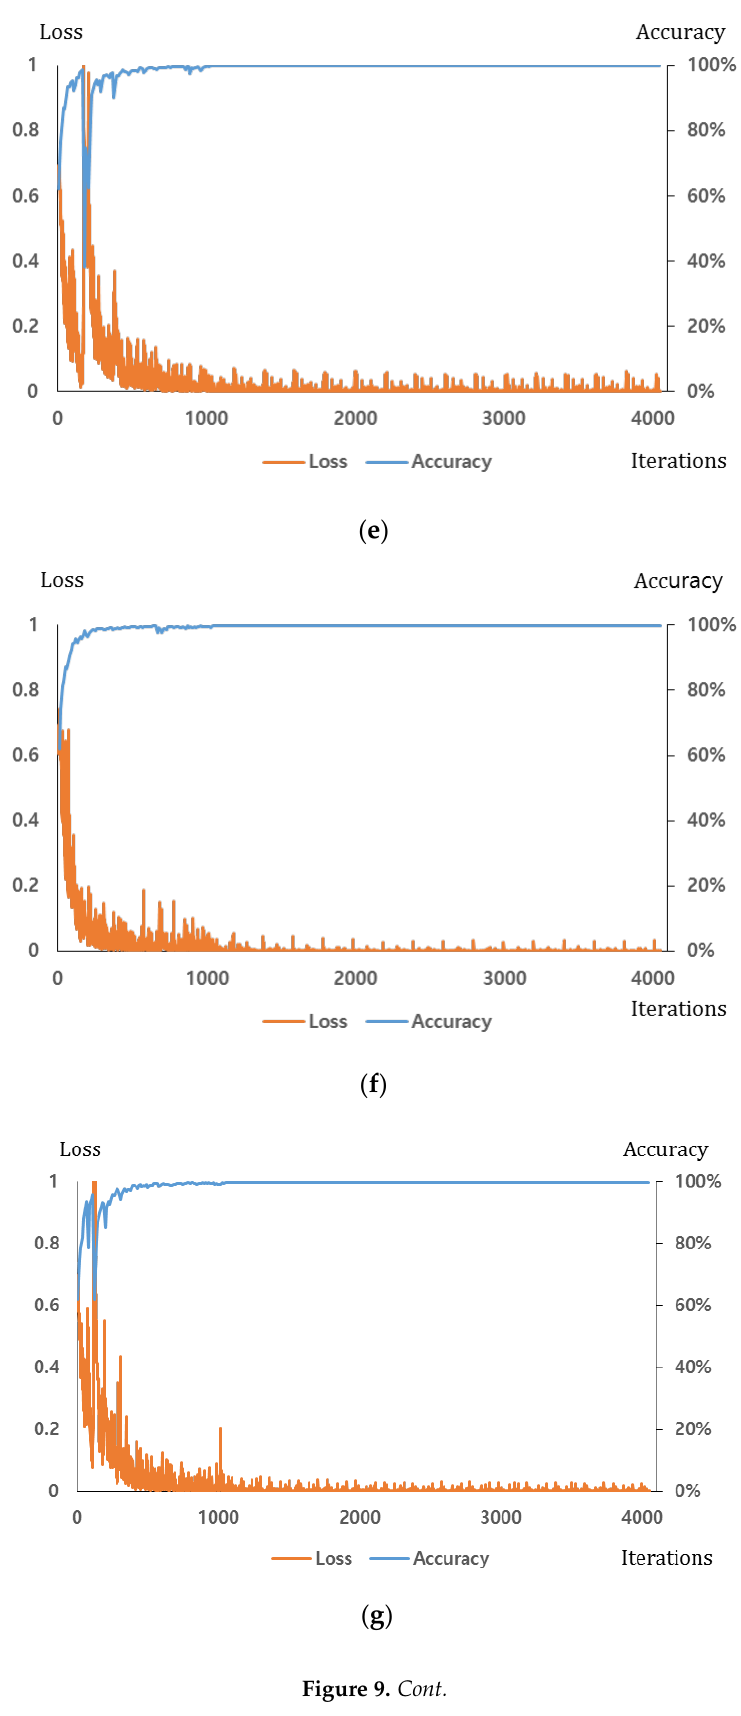
( h ) Figure 9. Loss and accuracy graphs of the training procedure: ( a ) the 1st fold (visible light candidate images); ( b ) the 1st fold (FIR candidate image); ( c ) the 2nd fold (visible light candidate images); ( d ) the 2nd fold (FIR candidate image); ( e ) the 3rd fold (visible light candidate images); ( f ) the 3rd fold (FIR candidate image); ( g ) the 4th fold (visible light candidate images); ( h ) the 4th fold (FIR candidate image). Unlike the gradient descent (GD) method, the SGD method defines the total number of iterations by dividing the training set by the mini-batch size, sets the training completion time until it reaches the total number of iterations (set as 1 epoch), and conducts the training for the preset number of epoch. The CNN training parameters are as follows: base_lr = 0.01, lr_policy = step, minibatchsize = 128, stepsize = 1013 (5 epoch), max_iter = 4054 (20 epoch), momentum = 0.9, gamma = 0.1, weight_decay = 0.0001, regularization_type = L2. The detail explanations of these parameters can be found in the following literature [53].Figure 9 shows the loss and the training accuracy for the CNN training process along with the number of iterations. The loss graph converges toward 0, and the training accuracy reaches 100% as the iteration of the four folds increase. At this condition, the CNN is considered to be fully trained. Figure 10 shows an example of 96 filters with 11 × 11 × 3 (as shown in Table 4) in the 1st convolutional layer, as identified through the training. For the purposes of visibility, the filters are resized five times as larger by bi-linear interpolation. In this study, the experiments used three types of databases, (a) the original DVLFPD-DB1, (b) the degraded DVLFPD-DB1 (see Section 4.2), which reflects Gaussian noise and Gaussian blurring into the original database, and (c) the open database (see Section 4.2), or the Ohio State University (OSU) color-thermal database [55]. Therefore, Figure 10 presents 96 filters - each gained from the CNN training by using these three types of databases. As shown in the following Table 7 of Section 4.1, the Bisector method has the highest performance among